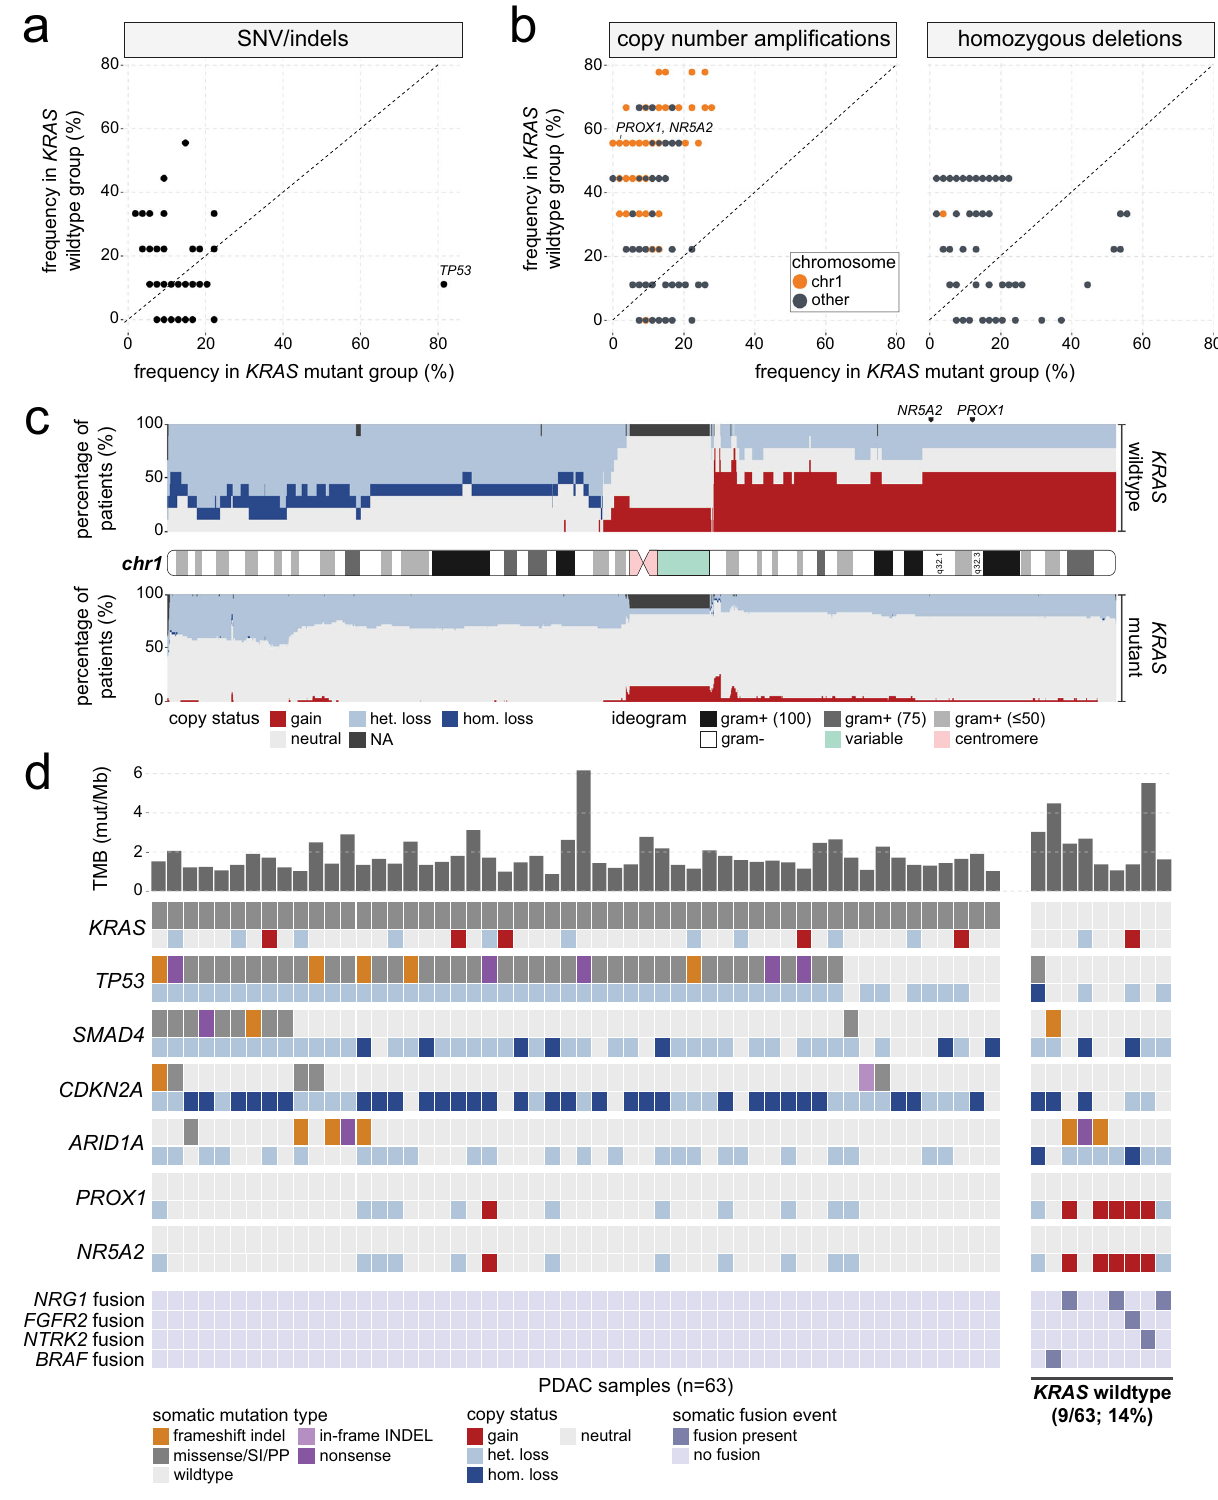
Fig. 2 | Patients with KRAS wildtype mPDAC harbor distinct fusion events that enable targeted therapeutic approaches. a Scatter plot comparing SNV/indel frequency across genes in KRAS wildtype versus mutant groups. b Scatter plot comparing copy number ampli fi cation (left) and deletion (right) events across genes in KRAS wildtype versus mutant groups. Colors indicate whether the gene is locatedonchromosome1(chr1). c StackedbarplotshowingCNVfrequencyacross the length of chr1 in KRAS wildtype (upper) and mutant (lower) samples. The